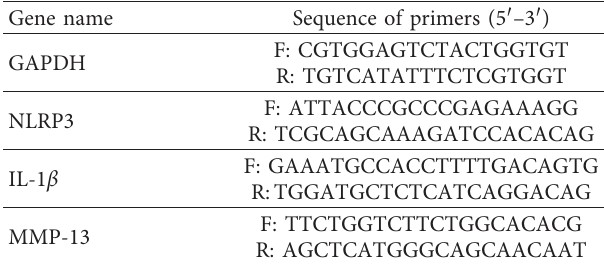
Table 1: Primers for each